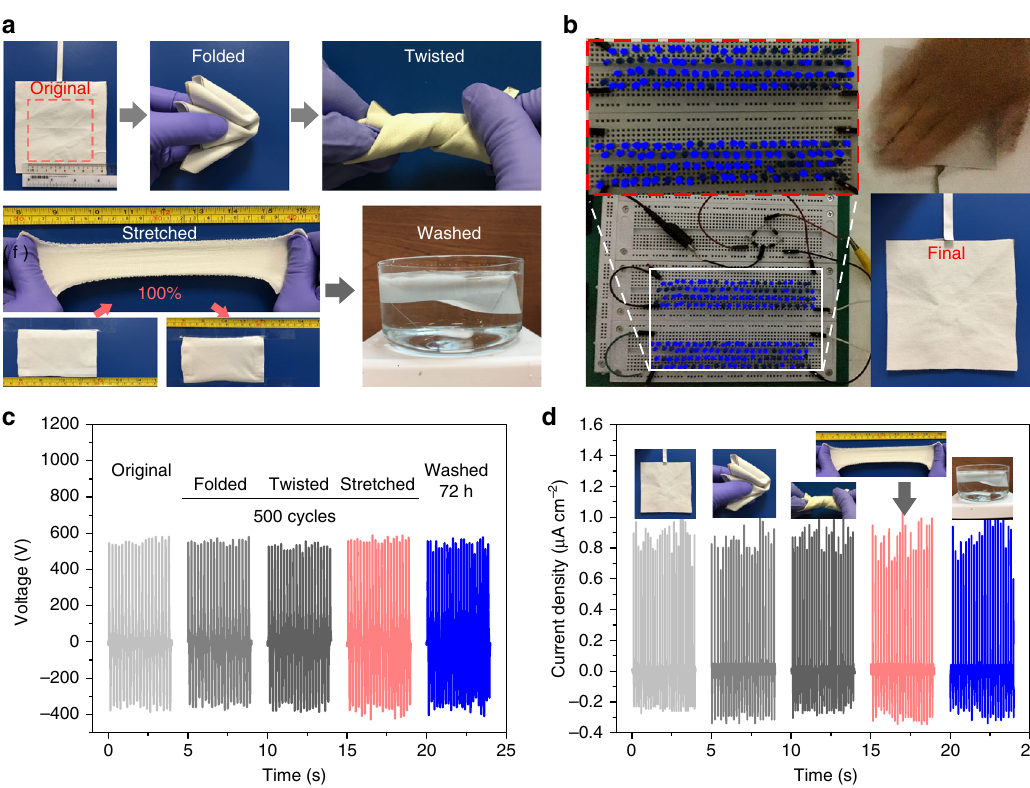
Fig. 4 Deformability and electrical stability of textile triboelectric nanogenerator under various extreme conditions. a Photographs demonstrating that the textile triboelectric nanogenerator (textile-TENG) possesses excellent endurance for successively experiencing deformations of fold, twist, and stretch, as well as severe washing. b Textile-TENG still can light up around 150 light-emitting diodes (LEDs) after extreme treatments. Touch motion (<5 N) with 4 Hz was used for driving the LEDs. c Output voltages and d current densities of textile-TENG after suffering various extreme deformations and severe washing. Stretching of 50% strain was performed as well for the